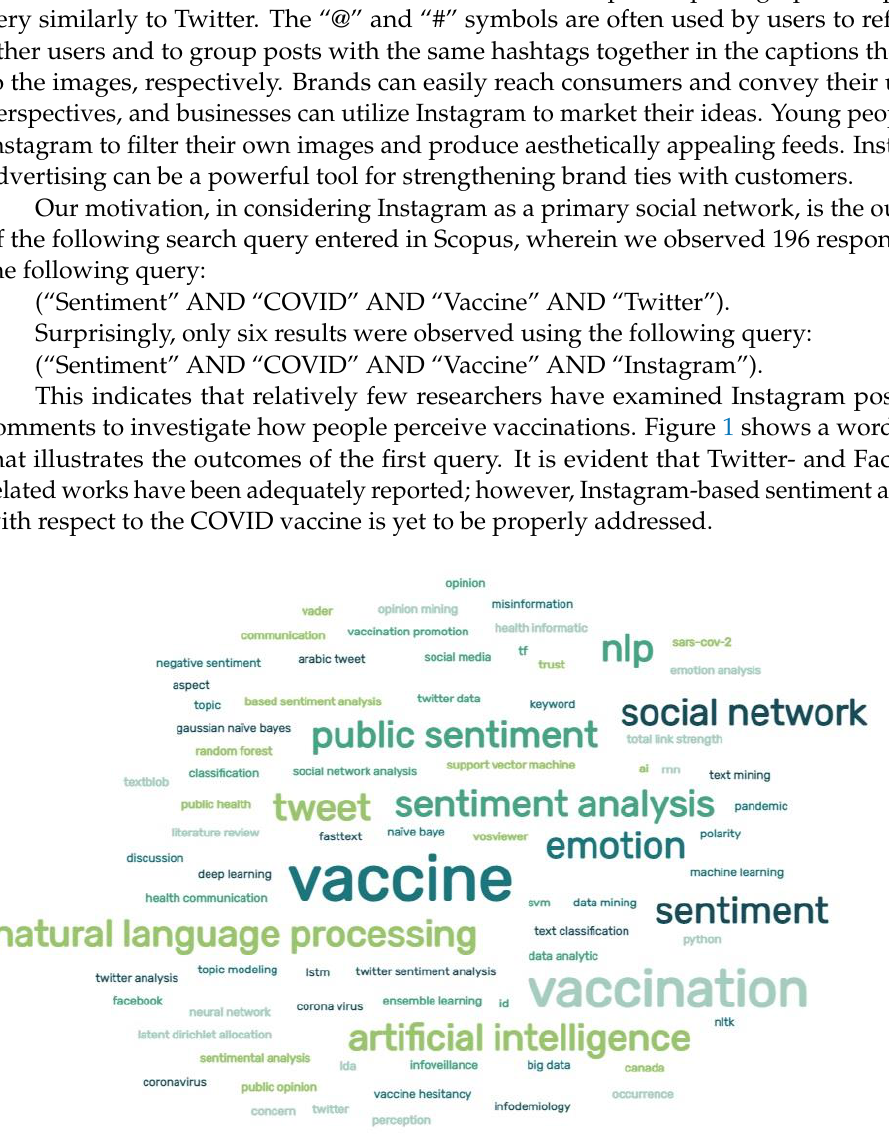
Figure 1. Word cloud for the Scopus outcomes based on the search of the authors’ keywords related to research on (“COVID” and “Twitter” and “sentiment” and “vaccine”). In this regard, Wawrzuta et al. examined the arguments offered by anti-vaxxers in relation to COVID-19 vaccinations on various social media platforms [15]. Amanatidis et